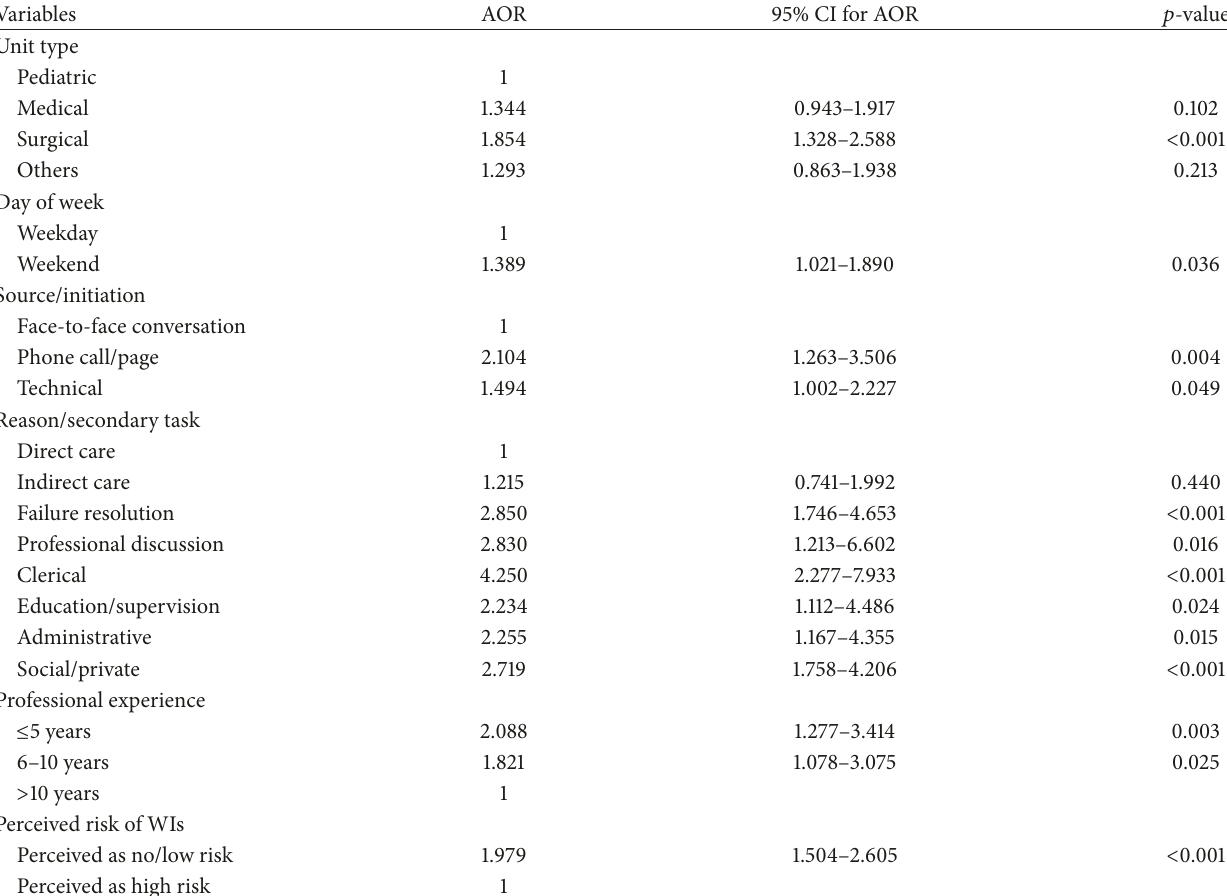
Table 4: Multivariate analysis of factors associated with major work interruptions ( 𝑛 = 278